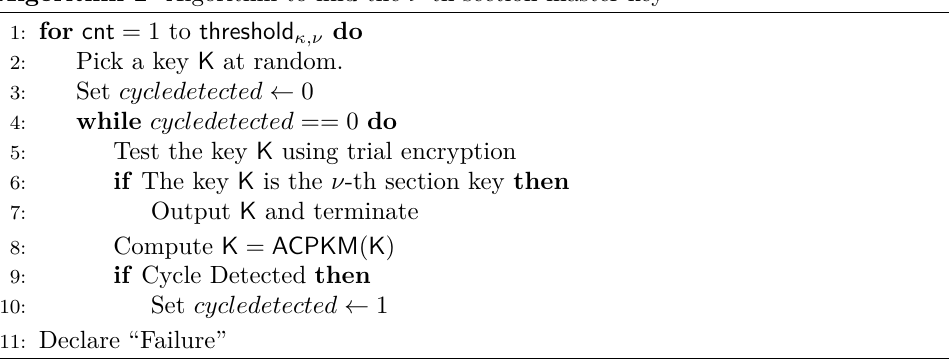
Algorithm 2 Algorithm to find the ν -th section master